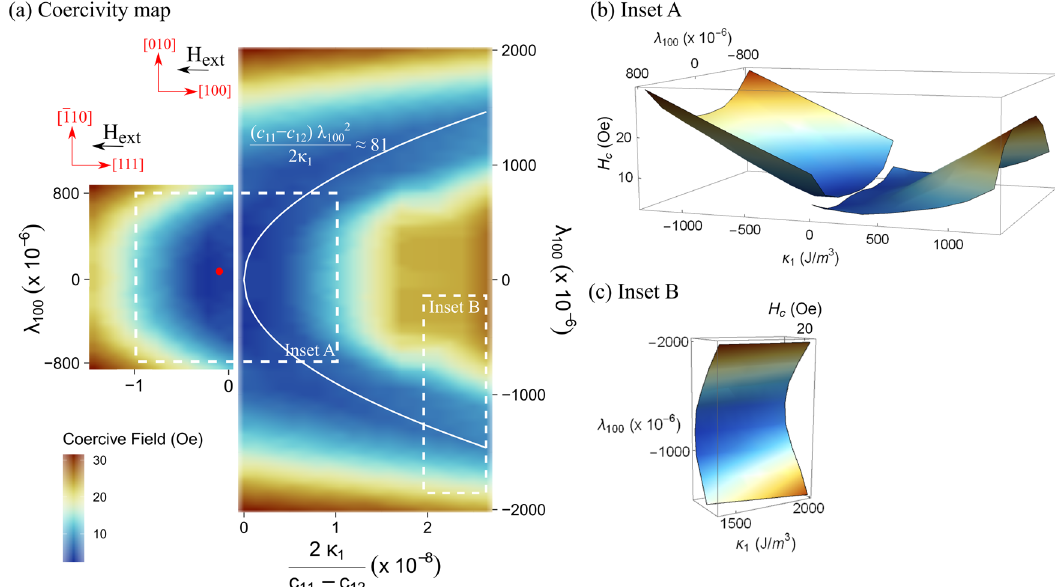
Fig. 2 The coercivity map as a function of the magnetocrystalline anisotropy κ 1 and the magnetostriction constant λ 100 . a We carried out a total of N = 2163 computations with the magnetostriction constant λ 111 set to zero. We fi nd that minimum coercivity is achieved when ð c 11 (cid:2) c 12 Þ λ 2 100 (cid:3) 81 . For comparison, the solid red dot corresponds to the coercivity of the permalloy composition. Note, the parabolic relationship 2 κ 1 is a best- fi t polynomial to the spread of coercivity data from our calculations. Alloys, such as the permalloy, lie close to the vertex of this parabola and we interpret this as the shortest distance to the parabola with a dimensionless constant of 81. The axes (in red) indicate the crystallographic directions along which coercivity values were measured for alloys with κ 1 > 0 and κ 1 < 0, respectively. The 3D surface contours of the coercivity values in ( b ) “ inset A ” and ( c ) “ inset B ” are shown. These plots show coercivity wells (regions of minimum coercivity) as κ 1 → 0 and κ 1 >> 0, respectively. Note, in sub fi gure ( b ), the 3D surface contour is discontinuous along κ 1 = 0 — we attribute this discontinuity to the transformation of easy axes from [100] to [111] crystallographic